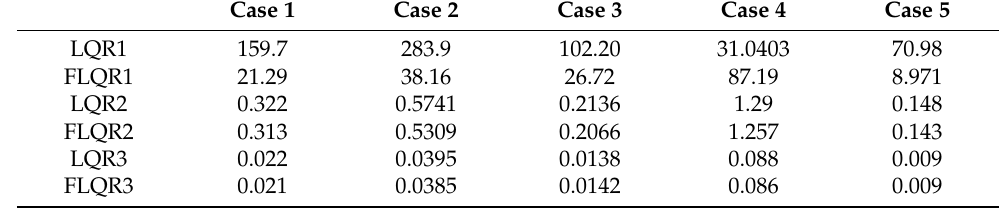
Figure 16. Case 4 comparison.